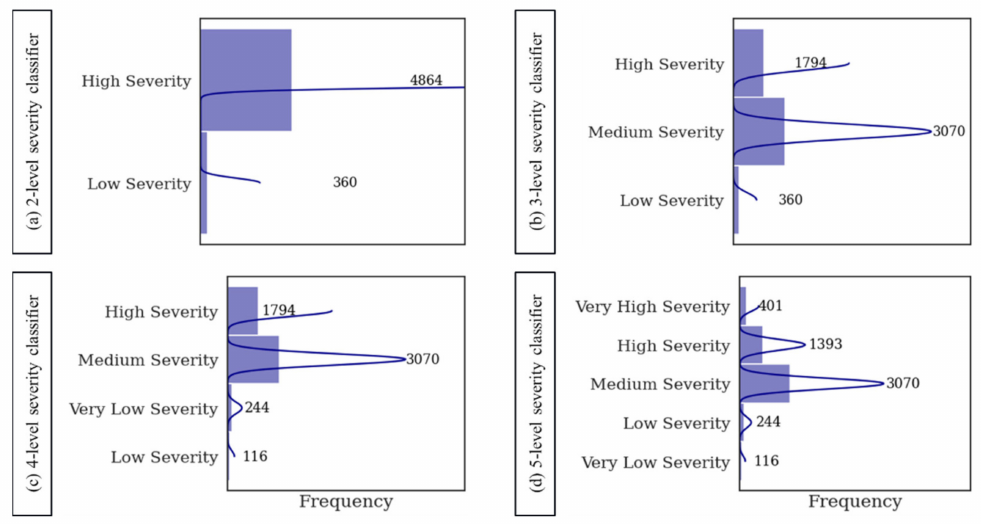
Figure 3. Classification of construction accident severity